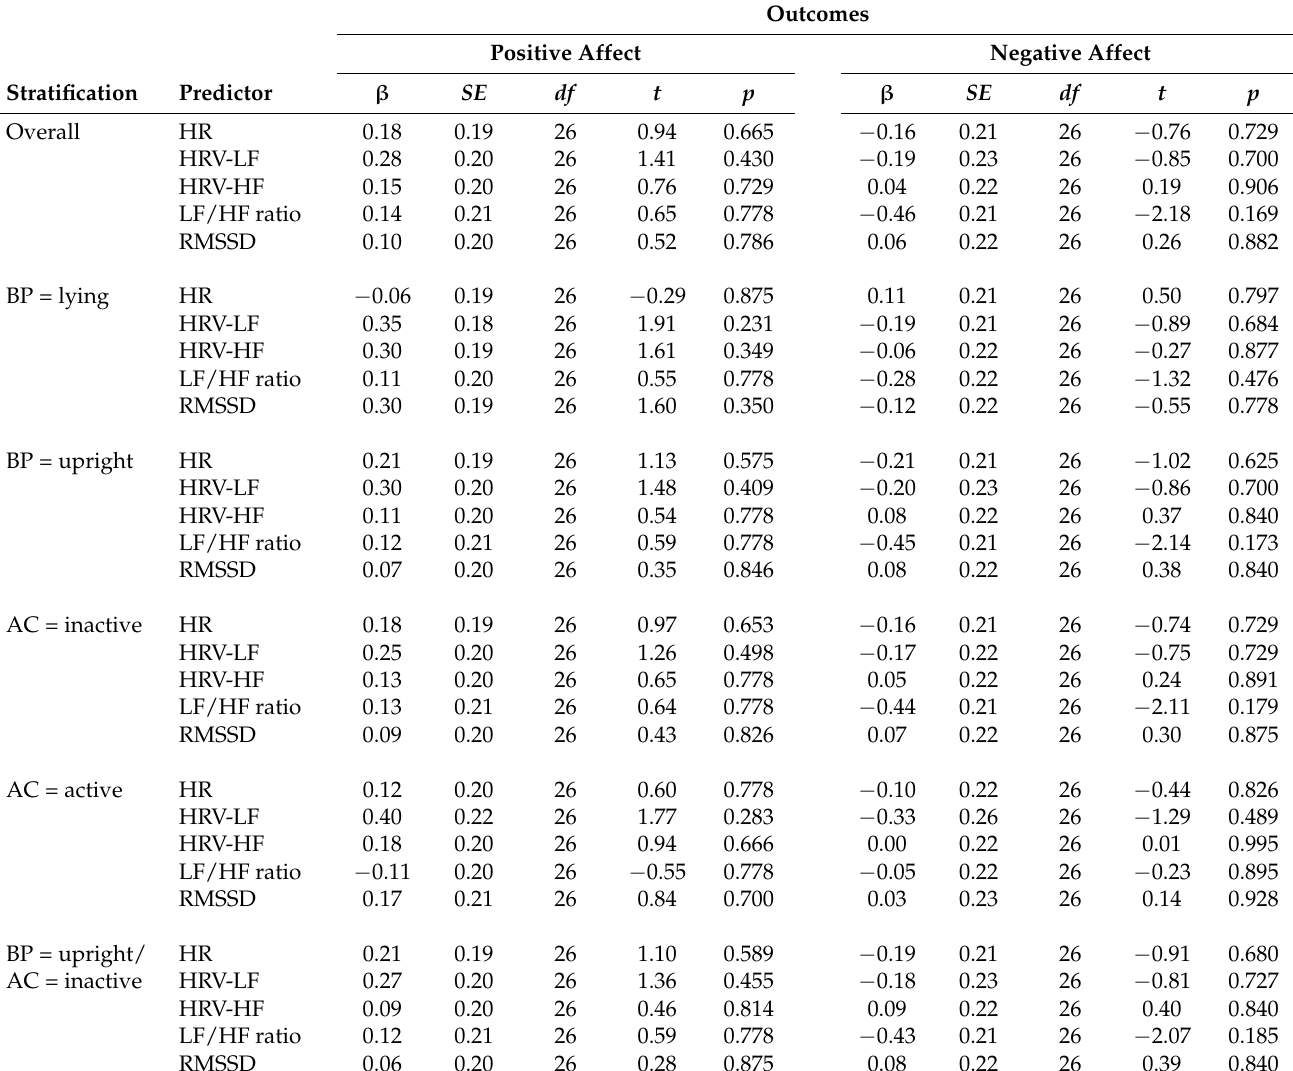
Table 7. Between-individual associations of HR and HRV with positive and negative affect sum